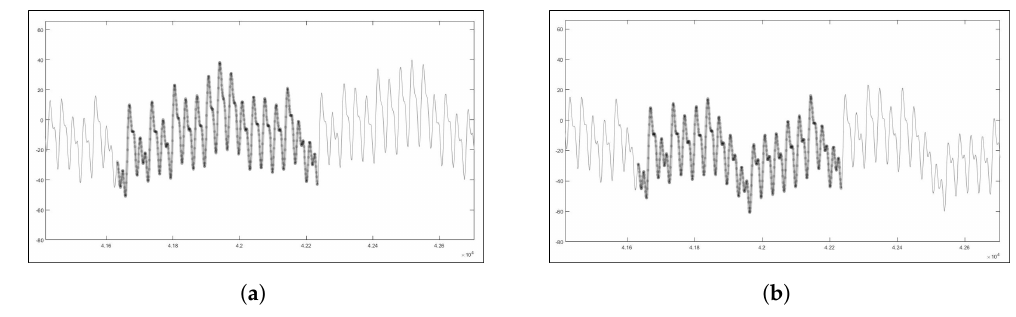
Figure 3. ( a ) power consumption trace when the subtracted result is negative; ( b ) power consumption trace when the subtracted result is positive.